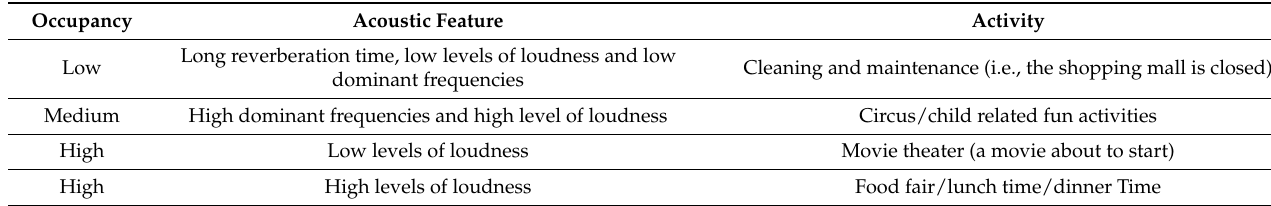
Table 6. Activity in a commercial